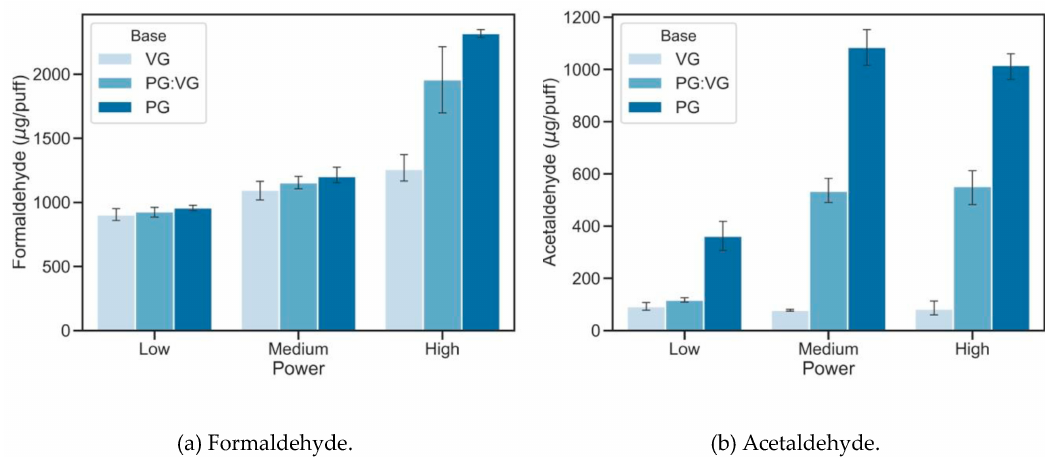
Figure 1. ( a ) Formaldehyde and ( b ) acetaldehyde levels (µg/puff) generated by combinations of base materials (100% VG, PG:VG 1:1 (v/v), and 100% PG) and device power outputs (6.4, 14.7, and 31.3 watt